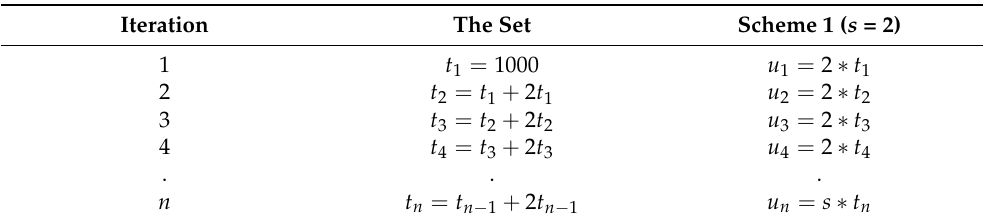
Table 4. The size of the sets and additions over iterations. t n is the training set size, u n is the size of increments, s is growth factor, while n = 1,2, . . . , n